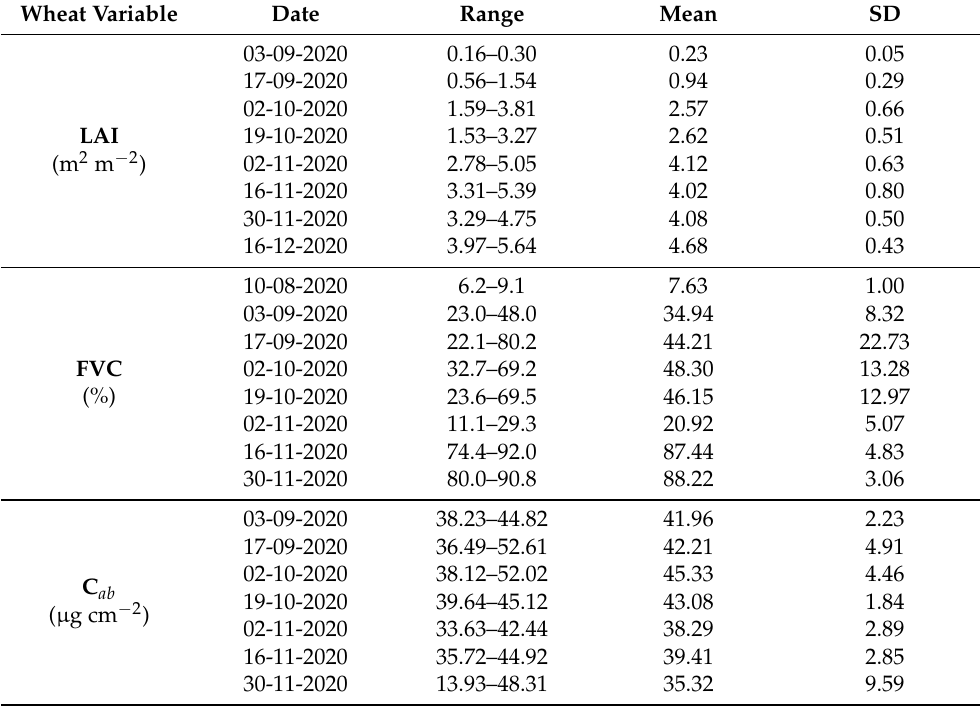
Table 2. Database of in-situ wheat traits with dates, ranges, mean values as well as standard deviations (SD) of the measurements. Wheat